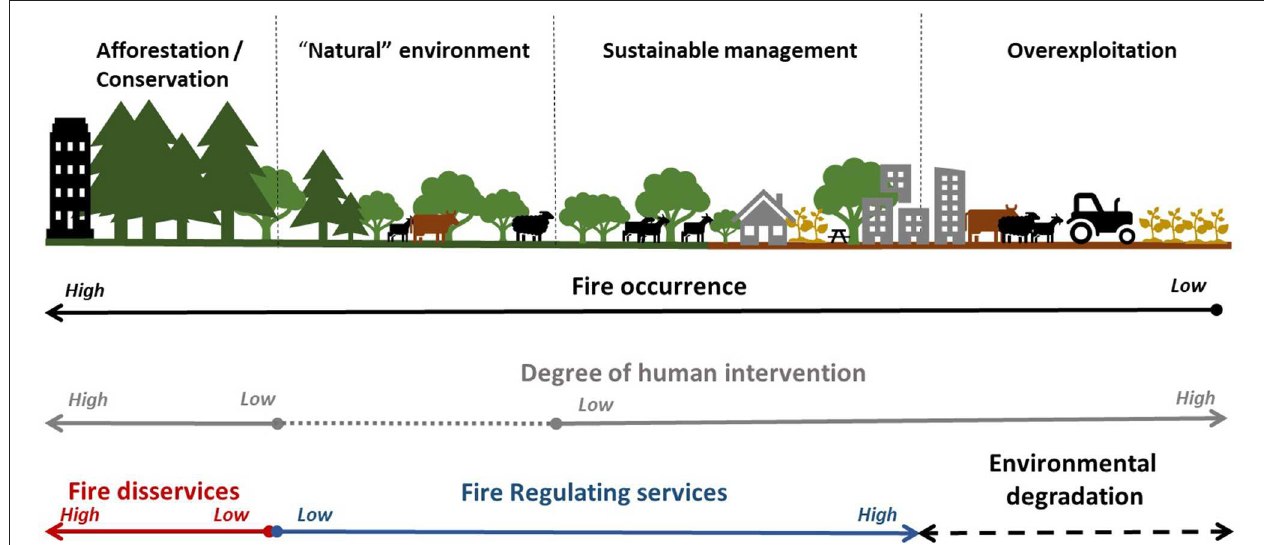
FIGURE 2 | Interactions between types of land use, the risk of forest fires, the degree of human intervention, the availability of fire-regulating services disservices which occurred, are occurring or should occur in the Haifa-Carmel